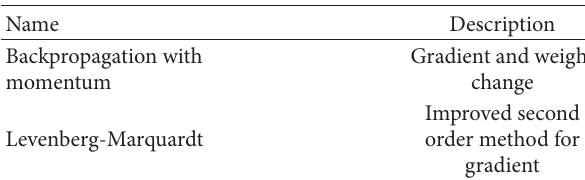
Table 2: Applied Training